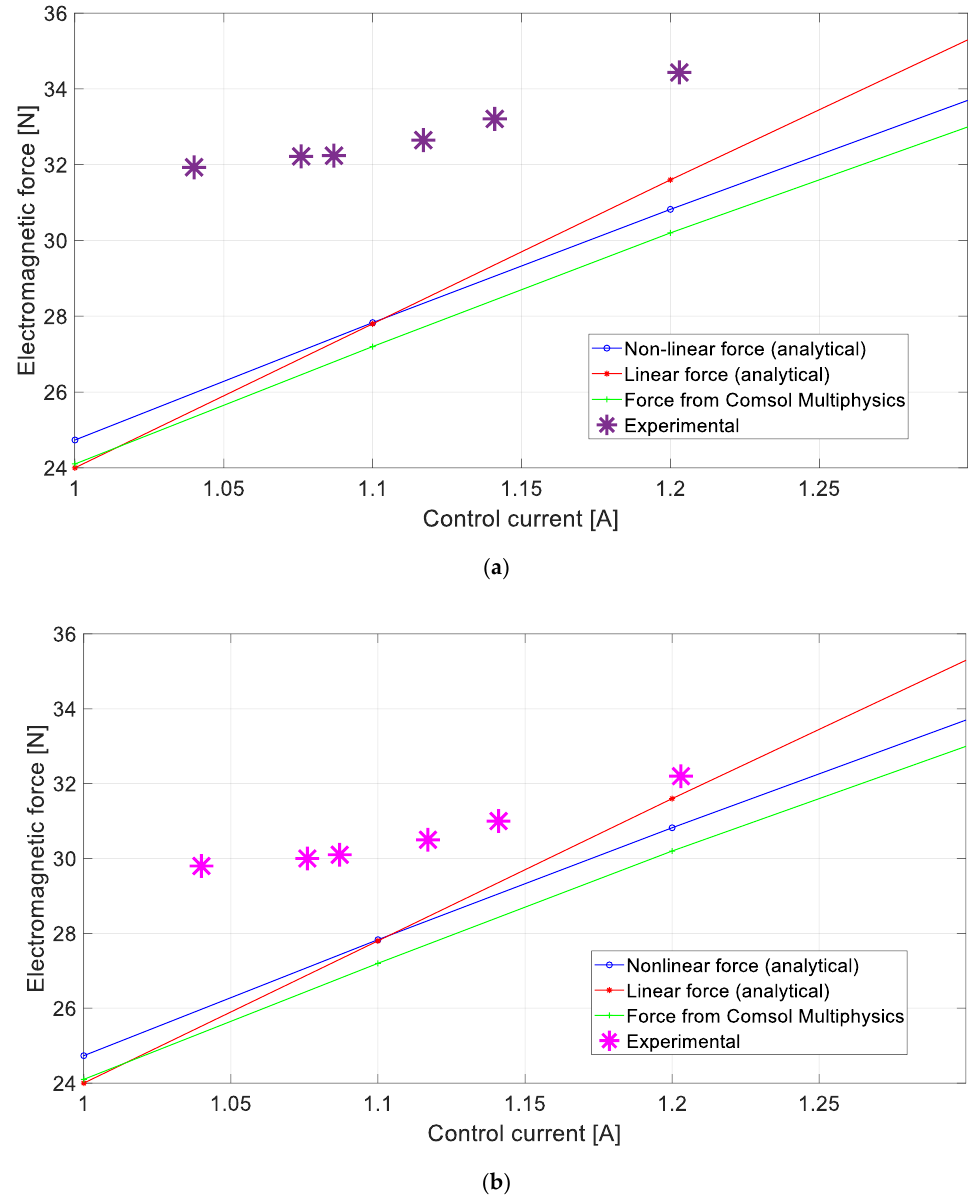
Figure 23. The resultant electromagnetic forces generated by the magnetic bearing for different values of the control current for the constant rotor–shaft raceway displacement equal to − 0.06 mm with experimental results: coefficients k x and k i obtained analytically ( a ); coefficients k x and k i determined with the use of Comsol Multiphysics software ( b ).